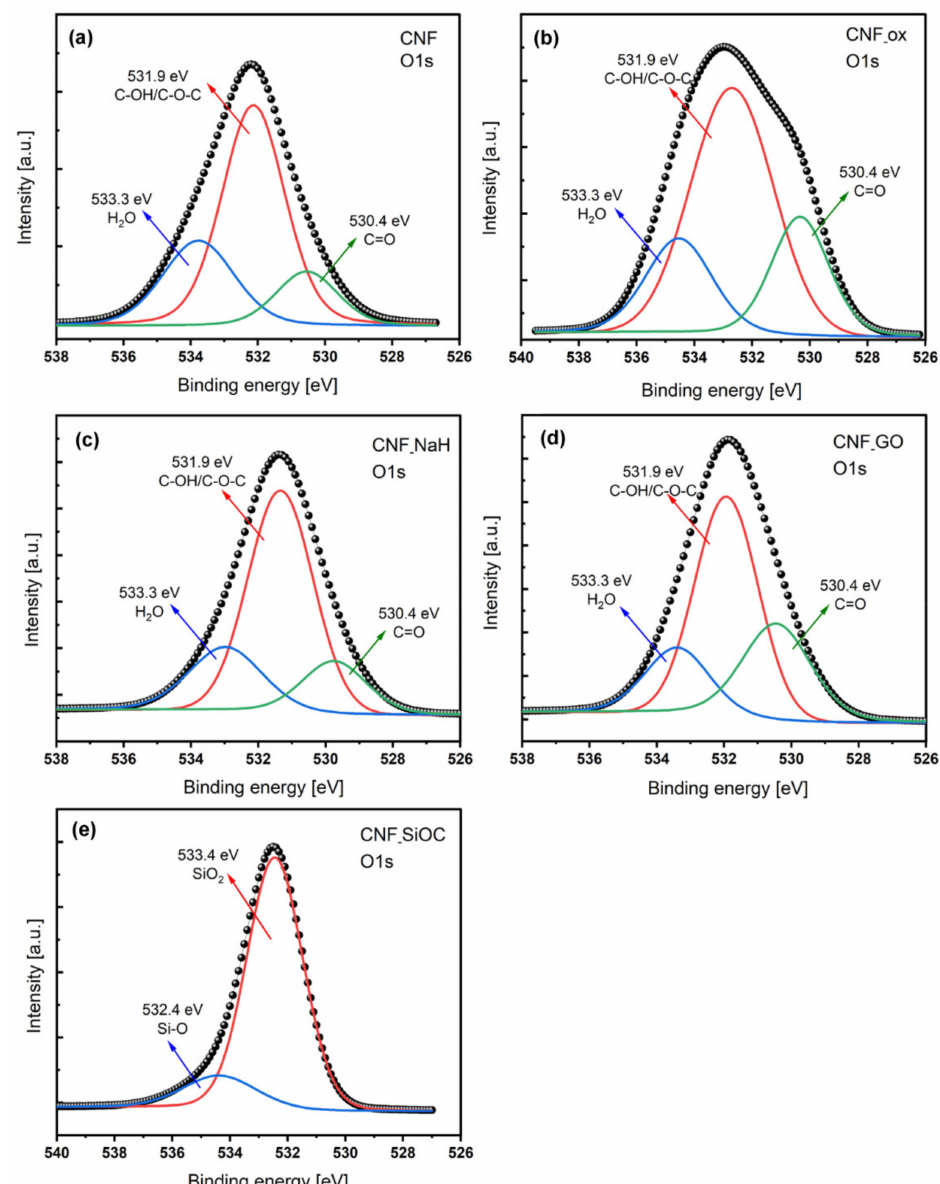
Figure 6. XPS spectra of carbon nanofibers before and after surface modification. Deconvoluted O1s ( a – e